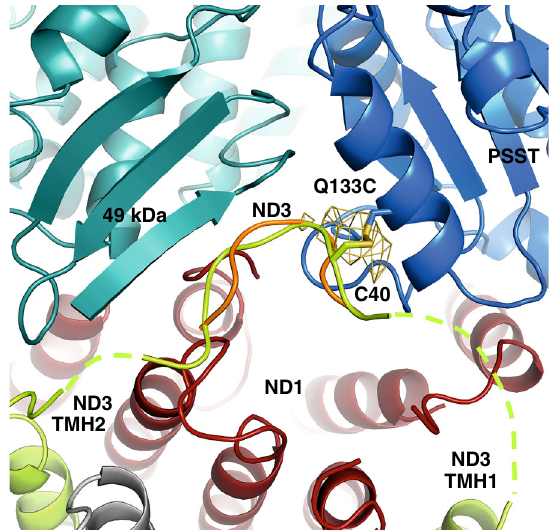
Fig. 5 Formation of the disul fi de cross-link immobilizes loop TMH1-2 ND3 without displacing it. Section of the crystal structure of complex I from mutant Q133C PSST showing the interface between membrane and peripheral arms in cartoon representation. The ND3 loop connecting TMH1 and TMH2 (light green) protrudes into the cavity formed by subunits PSST (blue), 49-kDa (blue-green), and ND1 (red). Residue C40 ND3 forms a disul fi de bond with C133 PSST (stick representation). This was con fi rmed by a strong peak in the sulfur anomalous difference Fourier electron density map (yellow mesh) which was absent when analyzing wild-type complex I crystals. Loop TMH1-2 ND3 from the superimposed structure of wild-type complex I [2] is shown in